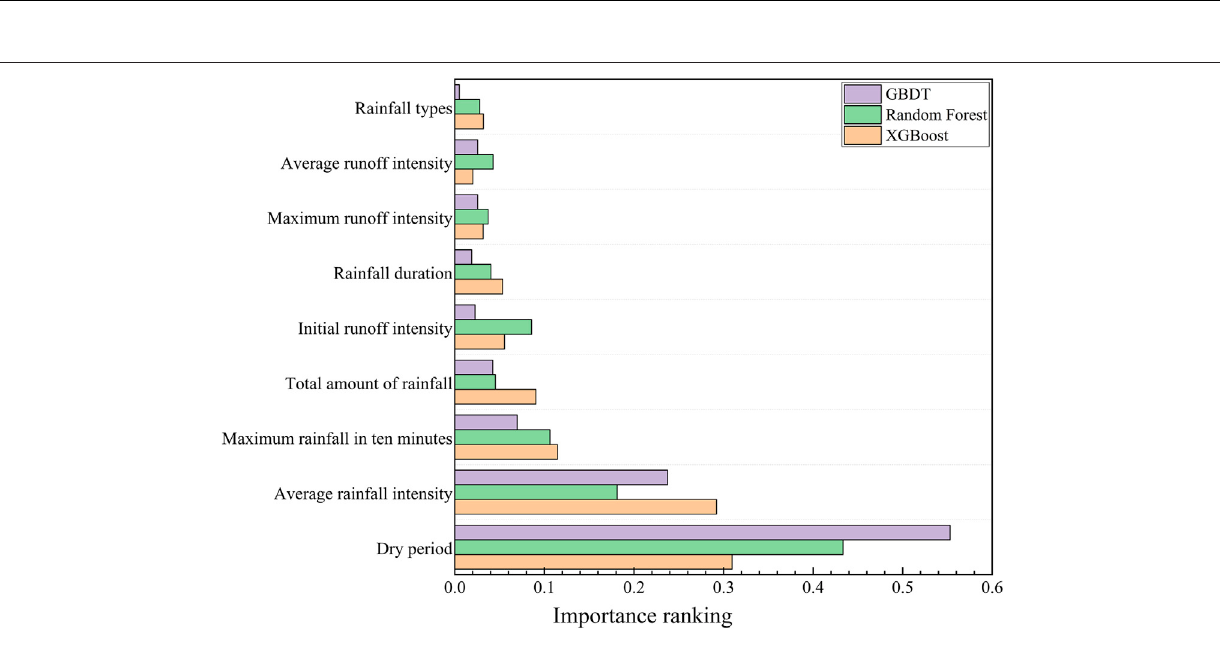
Frontiers in Environmental Science |